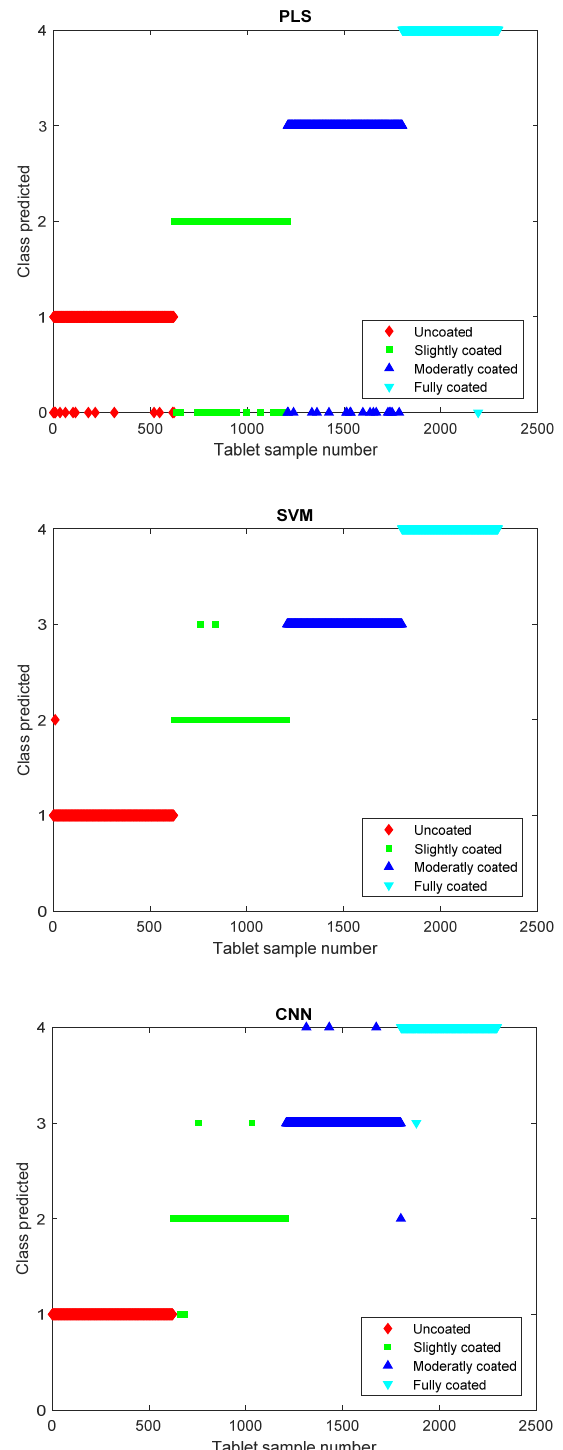
Figure 3. Partial least squares (PLS) model predicted class versus tablet sample number ( top ). Support vector machine (SVM) model predicted class versus tablet sample number ( middle ). Convolutional neural network (CNN) model predicted class versus tablet sample number ( bottom ).